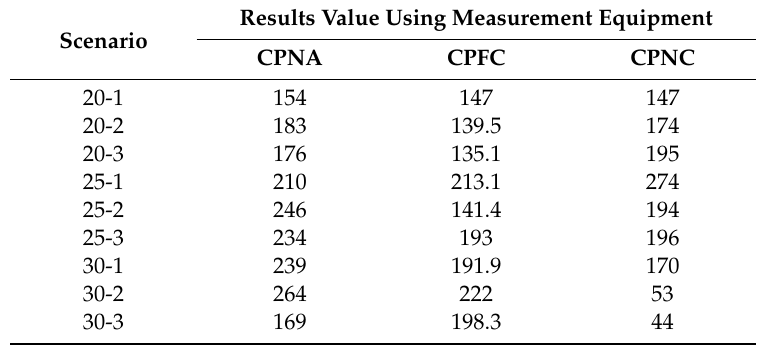
Table 8. Results value (relative distance) using measurement equipment, [cm].